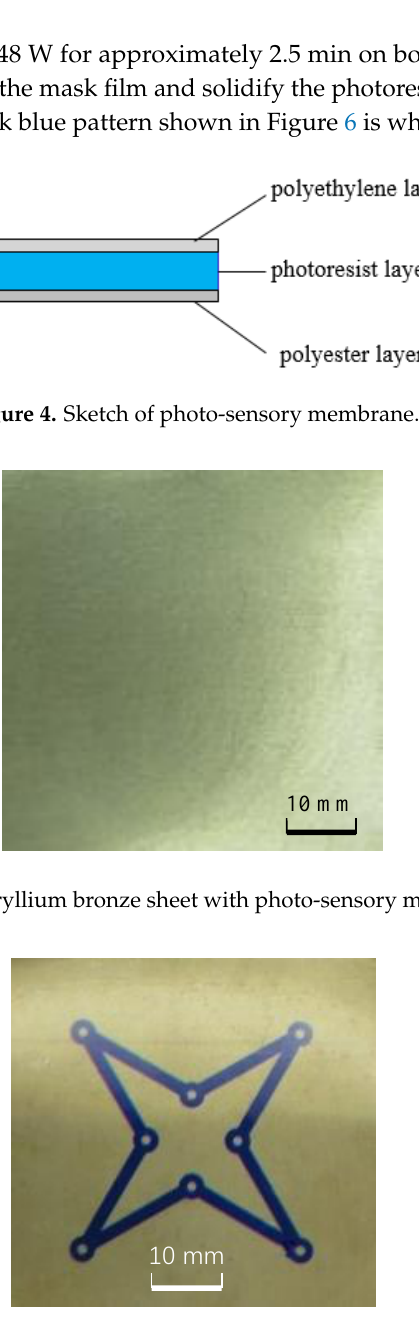
Figure 6. Exposed photo-sensory membrane.